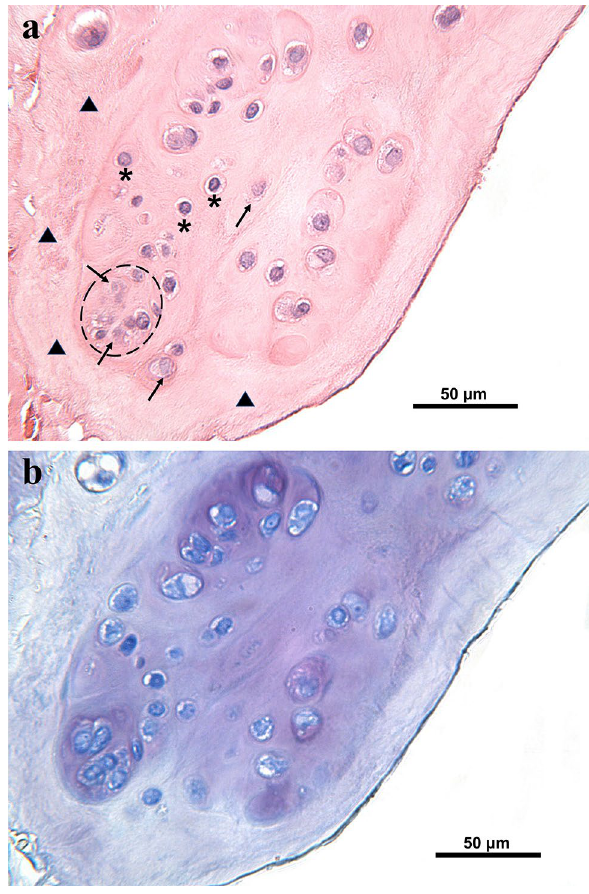
Figure 2. Representative meniscus histology from donor 9 stained with H&E and TB (avascular region, Grade 2): ( a ) Oedematous changes were observed in the meniscus surface zone, where the cells often appeared chondrocytic (*) sometimes forming clusters (dashed line). The area surrounding the oedematous region was typically acellular ( ▲ ) Note the necrotic appearance of some cells in this area and within the clusters ( ↗ ); ( b ) A higher intensity of TB staining was observed in the oedematous